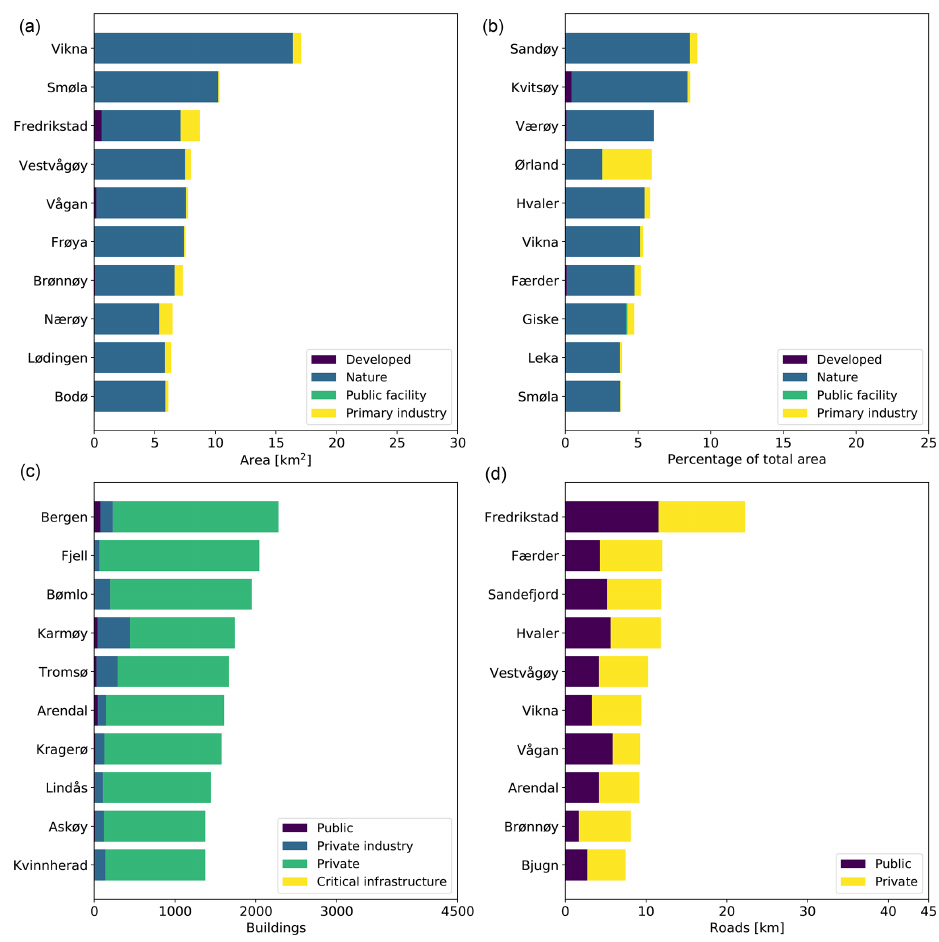
Figure 12. The 10 municipalities with the most land area (a, b) , buildings (c) , and roads (d) affected by a 200-year storm surge hazard at present sea